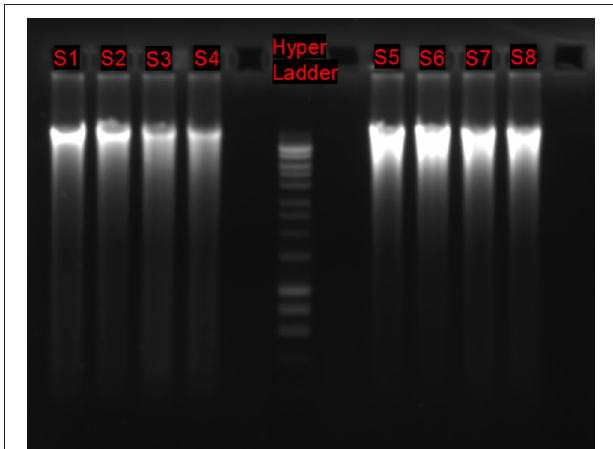
FIGURE 3 | DNA integrity of 8 environmental samples processed as described in the present protocol. DNA extraction was performed using the PowerMax Soil DNA Isolation Kit. HyperLadder TM 1